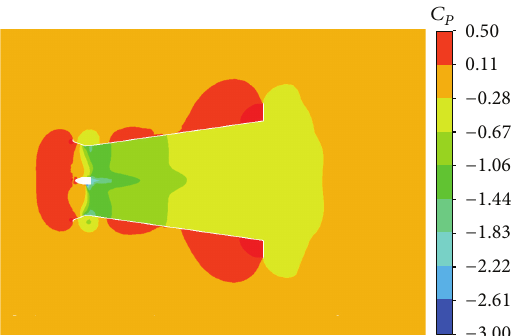
Figure 19: Static pressure distribution at 𝜆 = 6.5 (Runner + C.D. (Type D)).